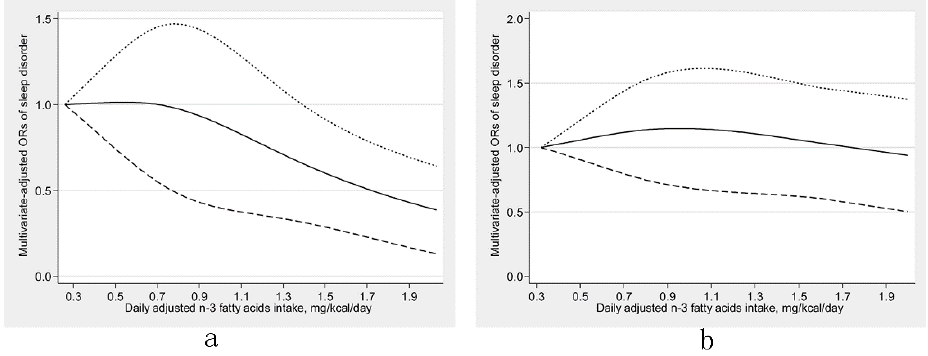
Figure 2. Restricted cubic spline model of the odds ratios (ORs) of sleep disorders with dietary ω-6:ω-3 ratio. The solid line and dashed lines represent the estimated ORs and the 95% confidence intervals, respectively.